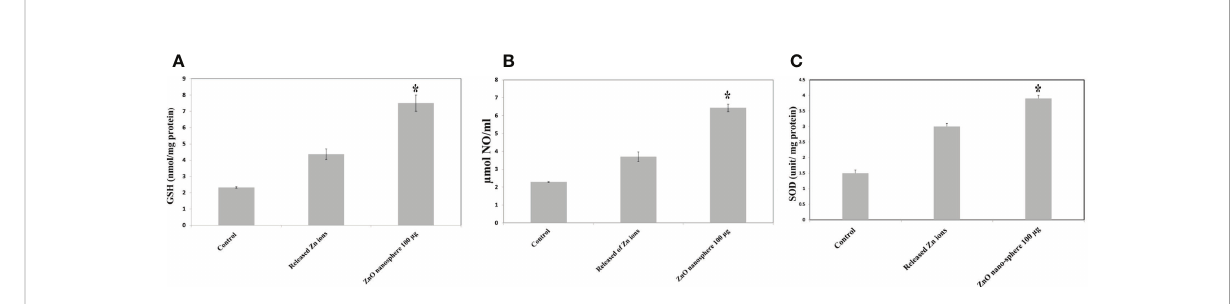
FIGURE 12 Antioxidant assay of human Hepatoma (HuH7) cells after treated with 100 m g/mL ZnO NSs and released Zn ion for 24 hour. *Statistically signi fi cant difference as compared with the controls (P > 0.05 for each). (A) Glutathione (GSH) (B) Superoxide dismutase (SOD) (C) Nitric oxide (NO).